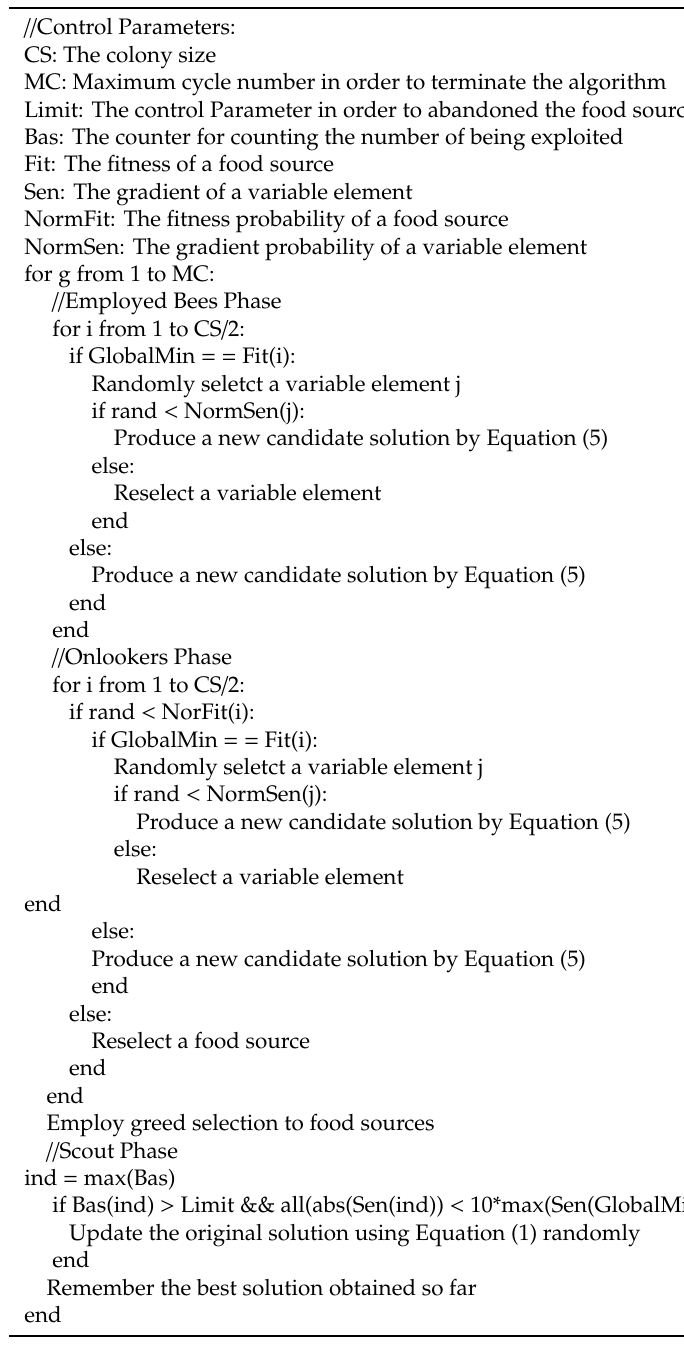
Table 1. Pseudo code of the Gbest-guided ABC algorithm with gradient information (GABCG)